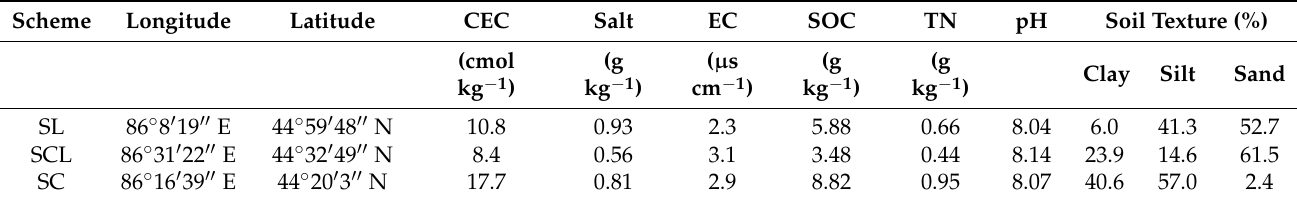
Table 1. Information on the sampled soils in this study. SL, SCL and SC indicate sandy loam soil, sandy clay loam soil and silty clay soil, respectively. CEC, SOC and TN represent cation exchange capacity, soil organic carbon content and total nitrogen content,